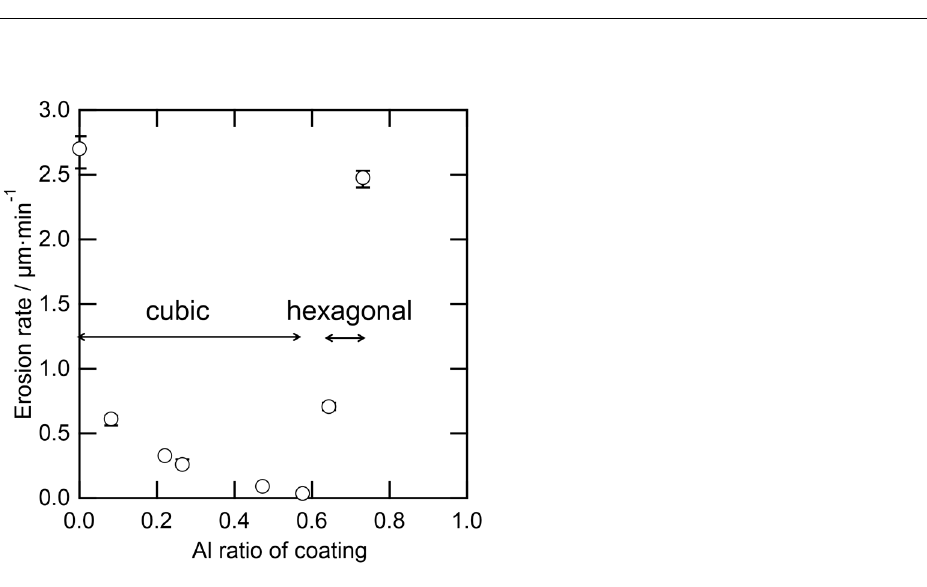
Figure 7. Erosion rate of TiAlN coatings with different Al compositions as measured by MSE test. The initial erosion rate of TiN is 2.7 µm/min and starts to decrease abruptly as the Al ratio increases up to 0.58. The lowest erosion rate of 0.036 mm/min is obtained at the Al ratio of 0.58, and a sudden increase is observed when the Al ratio increases more than 0.58. Figure 8 shows SEM and AFM images of TiAlN coatings with different Al ratios after a certain period during the erosion test.